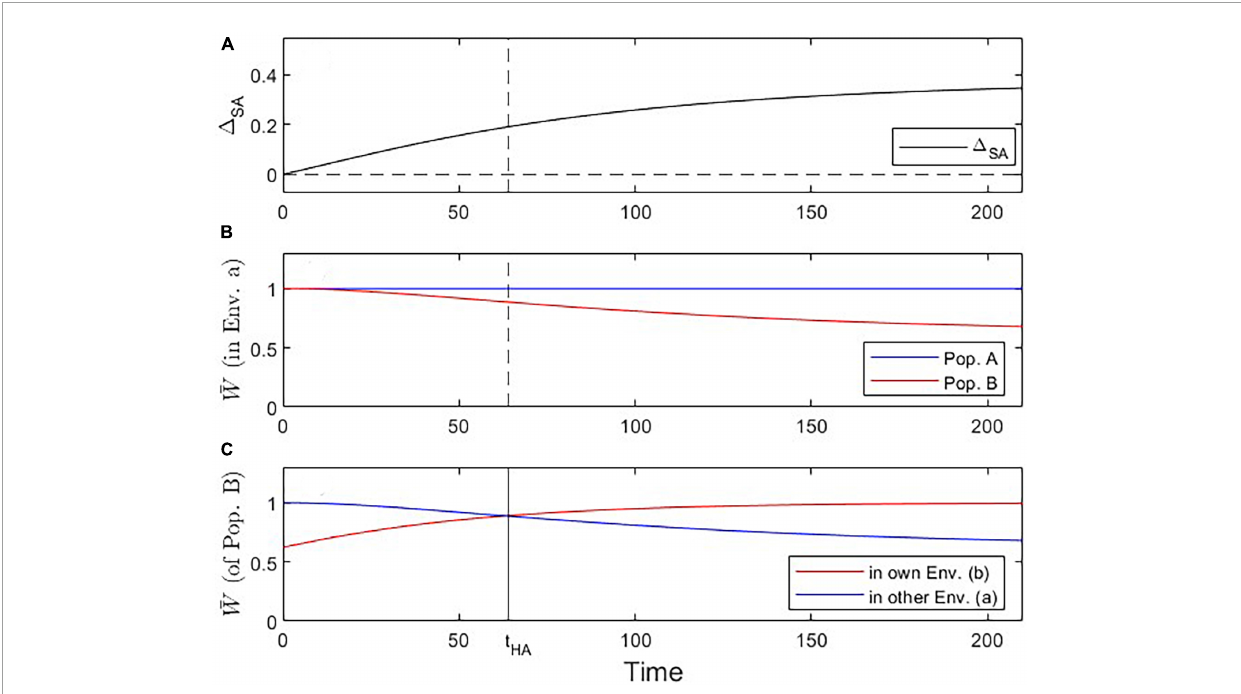
FIGURE2 Visualization of three critical checkpoints during the evolutionary dynamics under Scenario 1. (A) Evidence for local adaptation by the (cid:49) SA contrast criterion (satisfied for all t > 0). (B) Fitness of population A vs. B in environment a (addressing the Local vs. Foreign criterion; satisfied for all t > 0). (C) Fitness of population B in own vs. other environment (addressing the Home vs. Away criterion; t crit = 64; solid vertical line in this panel; dashed vertical line in other